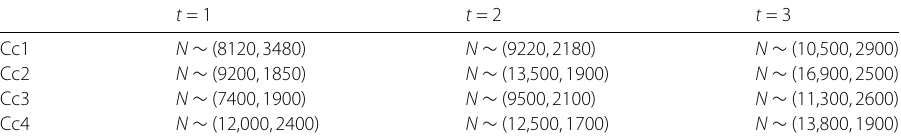
Table 6 Values used for demand sampling